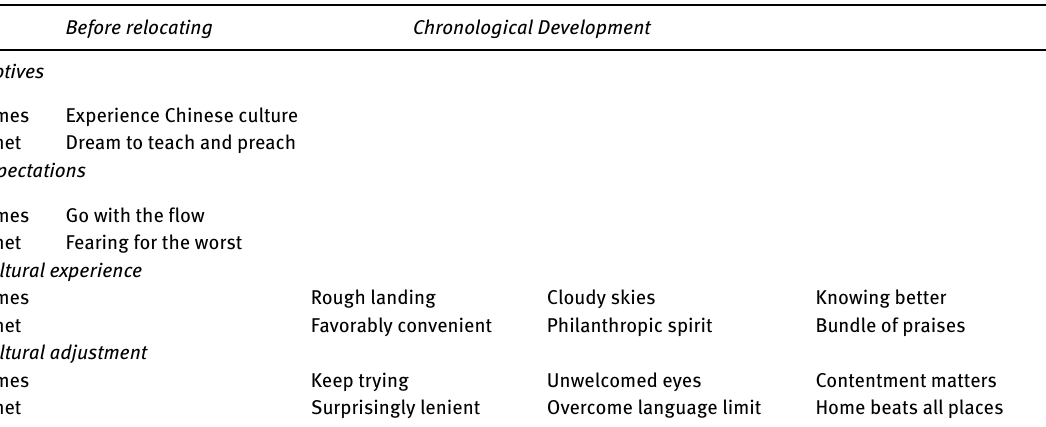
Table 3: Overview of James and Janet’s experience (compiled by the